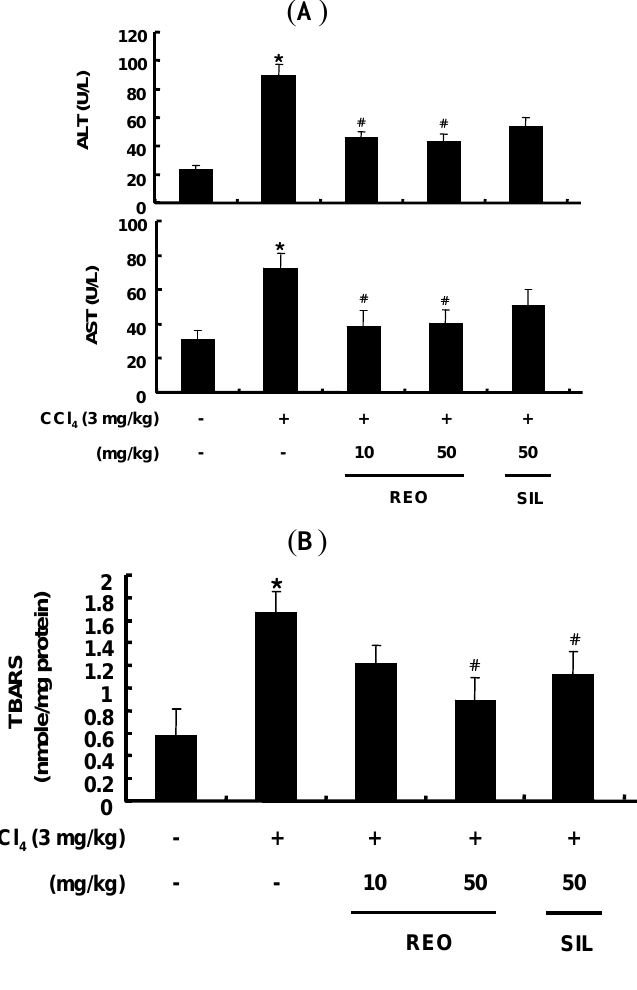
Figure 5. Effects of REO administration on the activities of ( A ) serum alanine transaminase, serum aspartate transaminase and ( B ) hepatic thiobarbituric acid reactive Substance (TBARS) content in CCl -treated mice. Each value represents the mean ± SD for 4 8 mice. * p < 0.05, significantly different from the unstimulated control group. # p < 0.05, significant differences from the CCl -treated 4